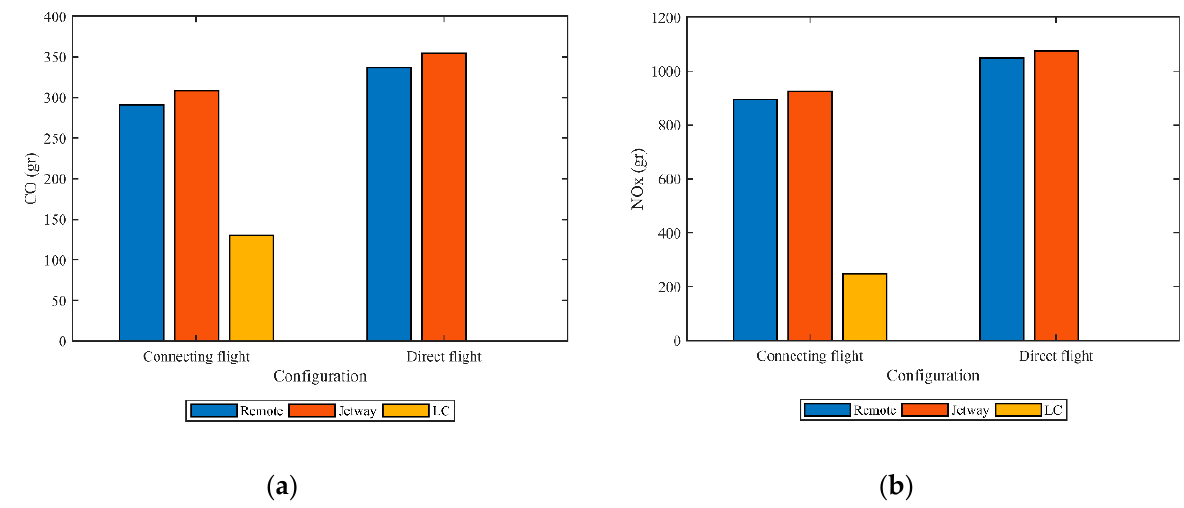
Figure 12. GSE emissions for different configurations and types of aircraft operations, ( a ) CO, ( b ) NOx.